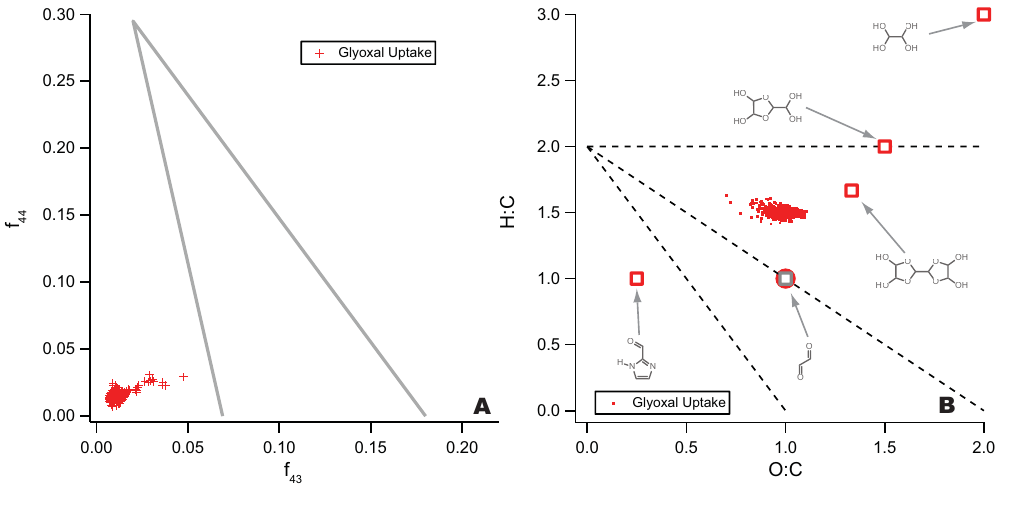
Fig. 8. (A) “Triangle plot” for SOA formed from reactive uptake of glyoxal onto wet ammonium sulfate aerosol. (B) Van Krevelen diagram for SOA formed from the uptake of glyoxal onto wet ammonium sulfate aerosol. Proposed SOA products are presented in boxes (Galloway et al., 2009; Kua et al., 2008; Loeffler et al., 2006). Oligomeric limits for glyoxal oligomerization condition is represented by a